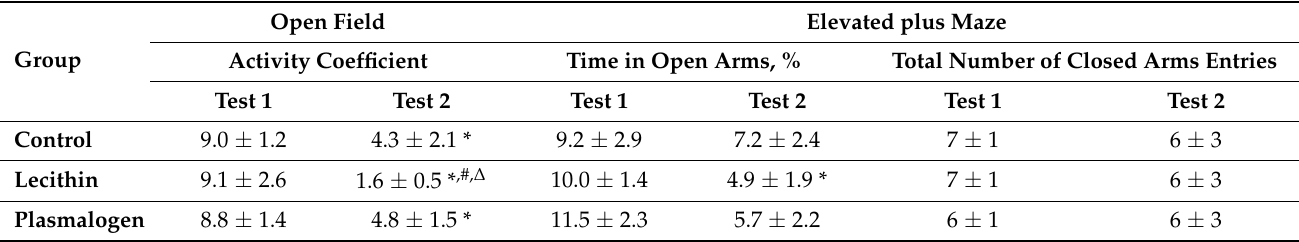
Table 1. Open field test and elevated plus maze test results.